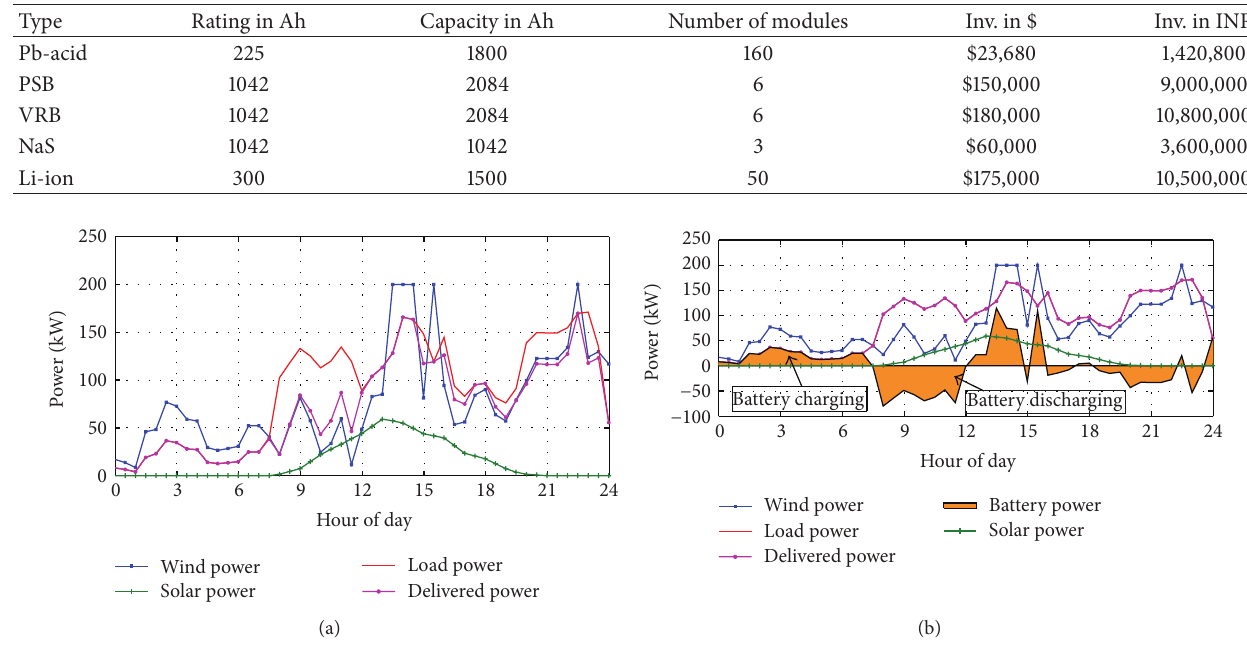
Table 7: Sizing of batteries with optimization.